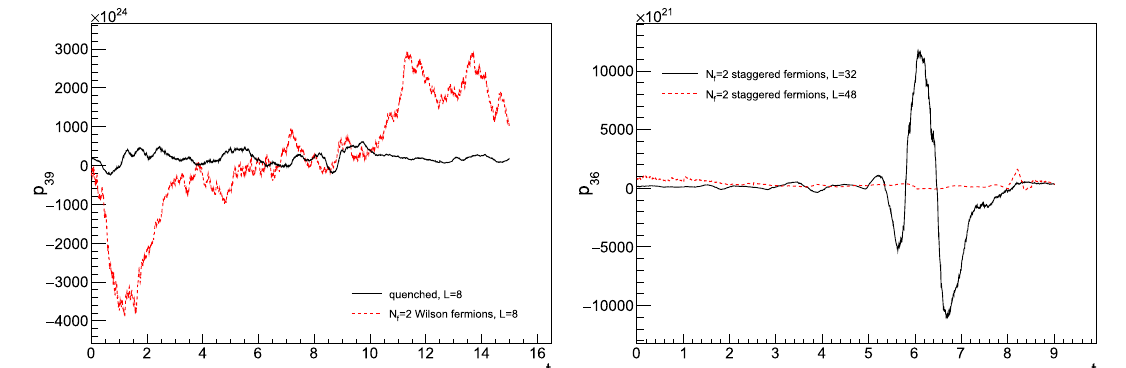
the quenched case we could extract the plaquette coefficient even from a small volume, while fermions introduce instabilities that can be mit-